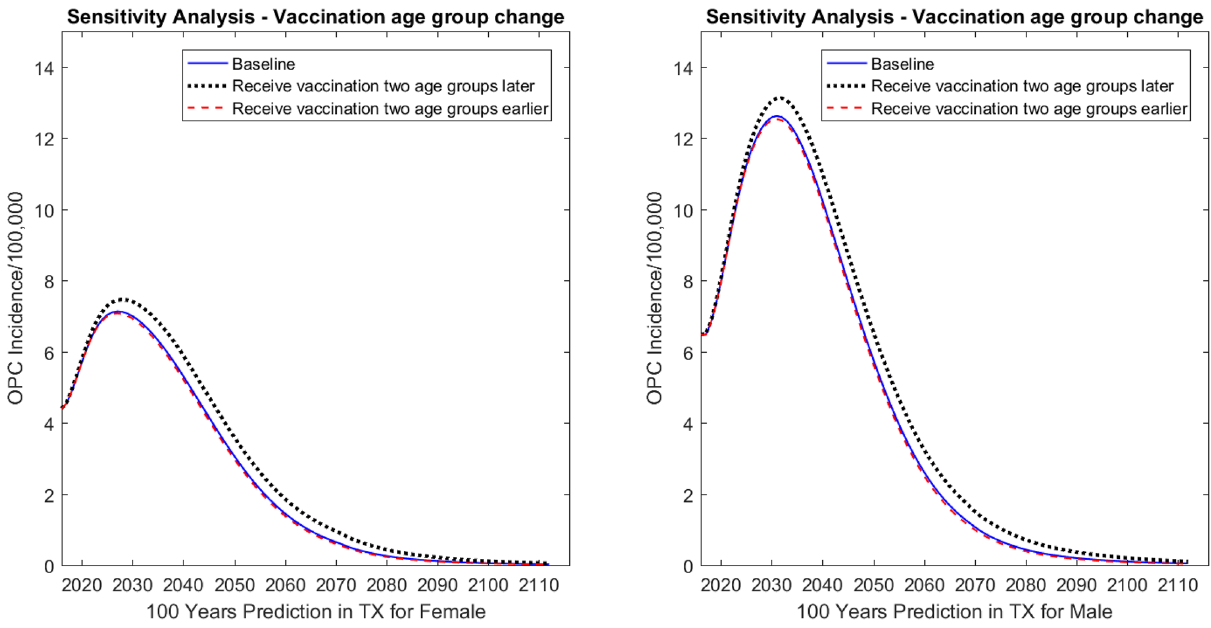
Figure 4. Sensitivity analysis: predicted effect of vaccination covered age groups on oropharyngeal cancer (OPC) incidence in Texas (TX). The graph on the left shows predictions for females; the graph on the right shows predictions for males.